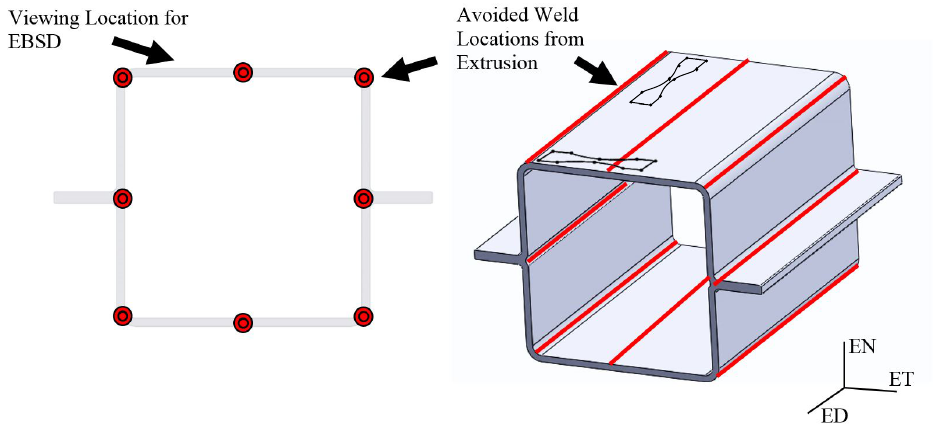
Figure 3. Magnesium AM30 crush rail is an extruded component used in an automotive shock absorption structure. This extrusion allows plane-strain conditions on the flat sections that promote a desirable double-fiber texture for studying twins as it promotes nucleation of multiple twin modes and variants in tension within neighboring grains.